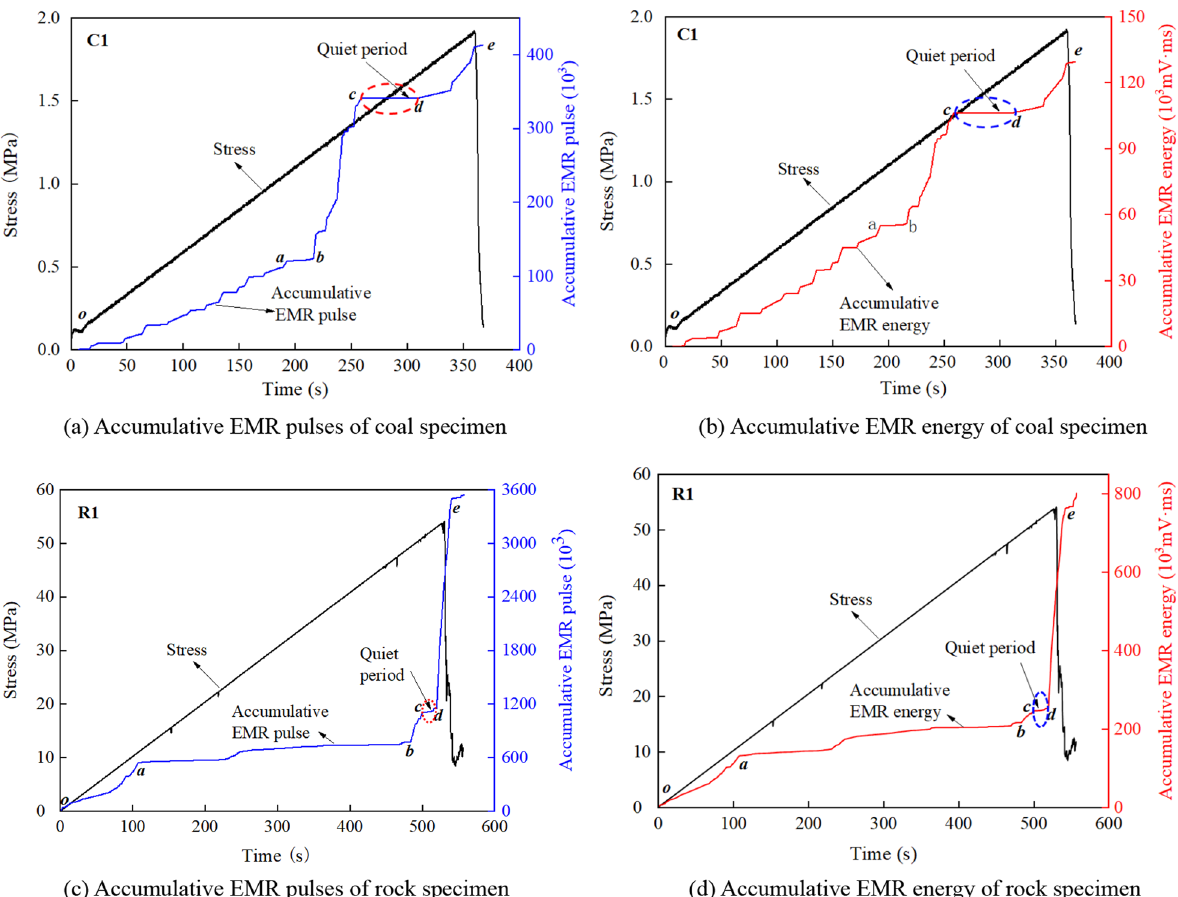
Fig. 5 Evolution law of EMR response of coal and rock specimens under uniaxial